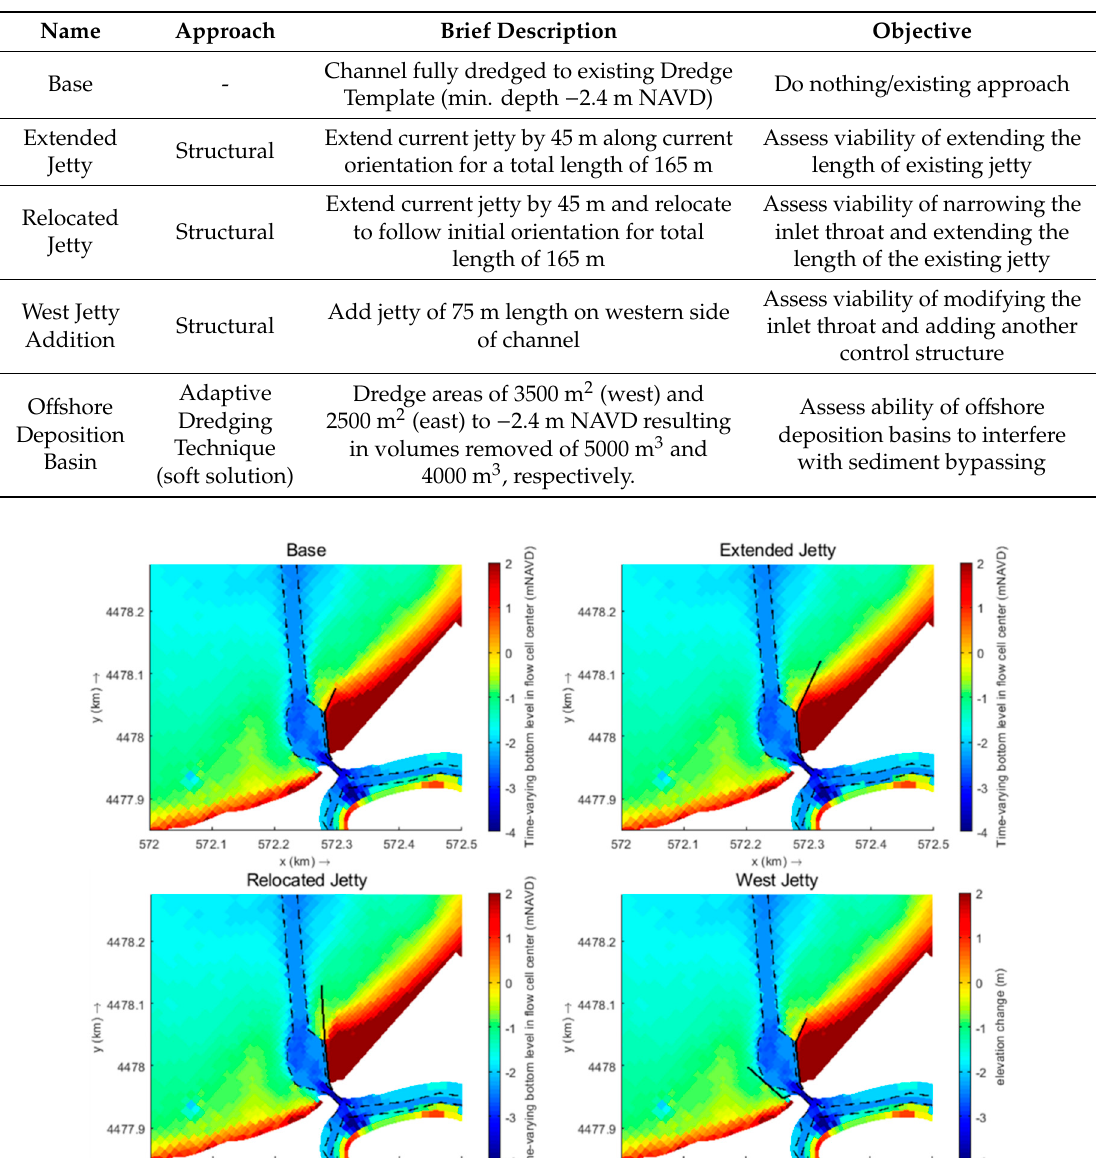
Table 7. Selected alternatives for modeling.